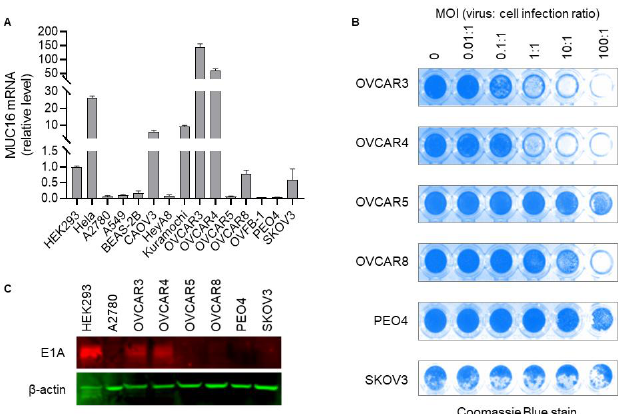
Figure 3. Replication of Ad5/MUC16-1040/TK-EGFP is dependent on CA-125 expression in a panel of selected ovarian cancer cell lines. ( A ). Relative MUC16 mRNA expression in selected cell lines. ( B ). Oncolysis induced by Ad5/MUC16-1040/TK-EGFP in selected human ovarian cancer cell lines. Coomassie blue stain assay: Live cells attached to plate culture surface were stained blue. Dead cells floated and were washed out, leaving the culture surface blank and devoid of stain. Intensity of blue indicates cell density. Punctuated white areas in the SKOV3 cells were non-specific detachment of cells. MOI: multiplicity of infection, virus:cell infection ratio. ( C ). E1A expression in selected ovarian cancer cell lines infected with Ad5/MUC16-1040/TK-EGFP.